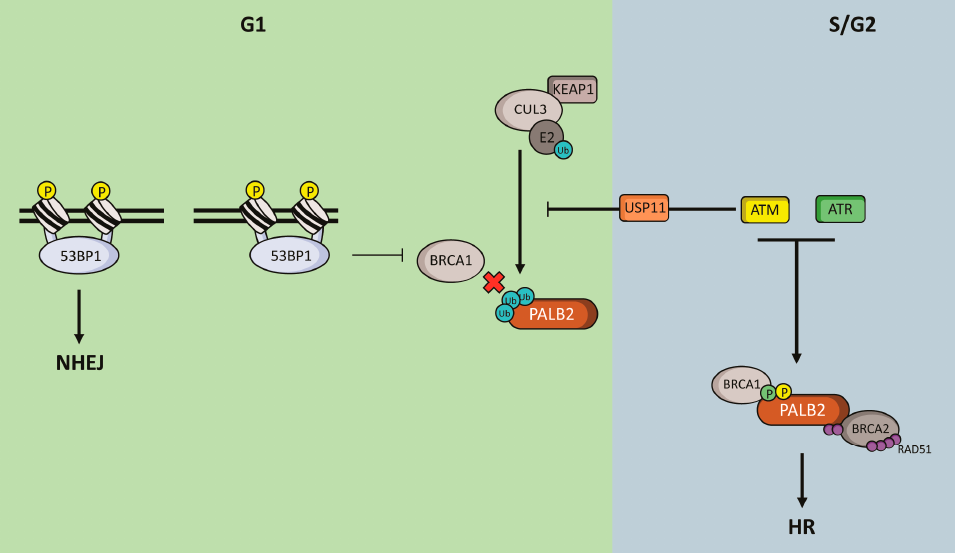
Figure 3. Cell cycle-mediated PALB2 regulation. Schematic representation of G1-dependent PALB2 ubiquitylation conducted by the CUL3 E3 ubiquitin ligase complex, mediated by KEAP1-PALB2 interaction. During the G1 phase (green background), 53BP1 inhibits BRCA1 recruitment to DSB sites, favoring NHEJ repair. Homologous recombination repair is also repressed through the inhibition of BRCA1-PALB2 interaction, a consequence of PALB2 ubiquitylation. In S/G2 (blue background), DNA damage activates the ATM-USP11 axis of DDR, which leads to the inhibition of the PALB2 ubiquitylation and consequently favors its association with BRCA1. Further, both ATM and ATR also phosphorylate PALB2, stimulating the DNA repair by HR through the BRCA1-PALB2-BRCA2-RAD51 complex.